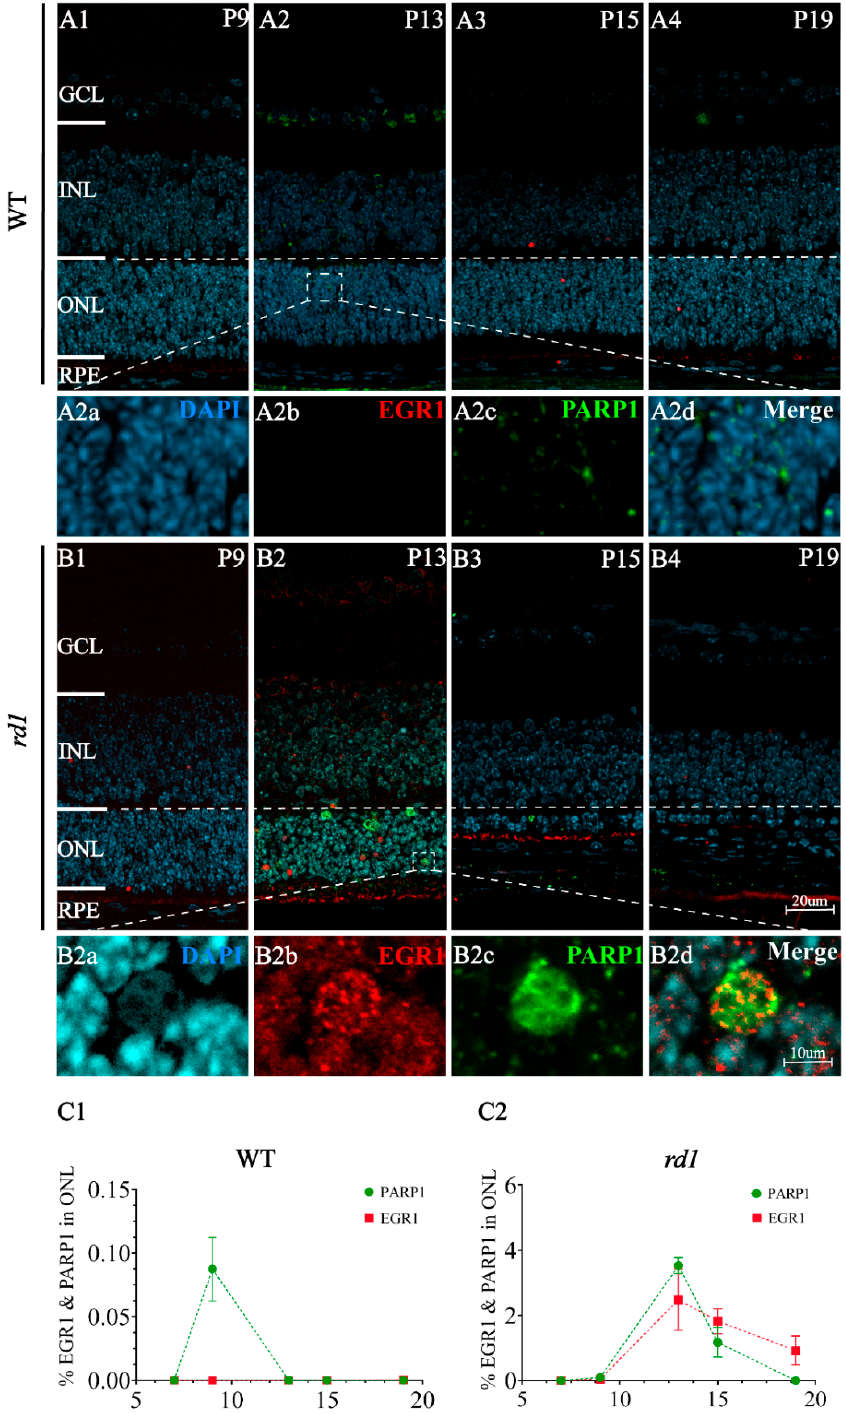
Figure 2. EGR1 and PARP1 spatially overlap in rd1 mouse photoreceptors. ( A1 – A4 , B1 – B4 ) Immu- nofluorescence staining detected EGR1 (red) and PARP1 (green) expression at time points ranging from P9 to P19 in WT and rd1 retinas in vivo. At P13, colocalization cells of EGR1 ( B2b , red) and PARP1 ( B2c , green) were detected in rd1 ( B2 , B2d Merge), while little colocalized positive cells of EGR1 ( A2b , red) and and PARP1 ( A2c , green) were detected in WT (A2, A2d Merge). DAPI (4 ′ ,6- diamidino-2-phenylindole; light blue) was used as a nuclear counterstain ( A2a , B2a ). ( C1 , C2 ) Quan- tification of EGR1- and PARP1-positive cells in the outer nuclear layer (ONL) of WT and rd1 retinas at P9, P13, P15, and P19. The images shown are representative of observations for at least six differ- ent specimens of each genotype. Error bars represent SD. INL = inner nuclear layer, GCL = ganglion cell layer, RPE = retinal pigment epithelium. Scale bar = 20 µm (10 µm in insert).